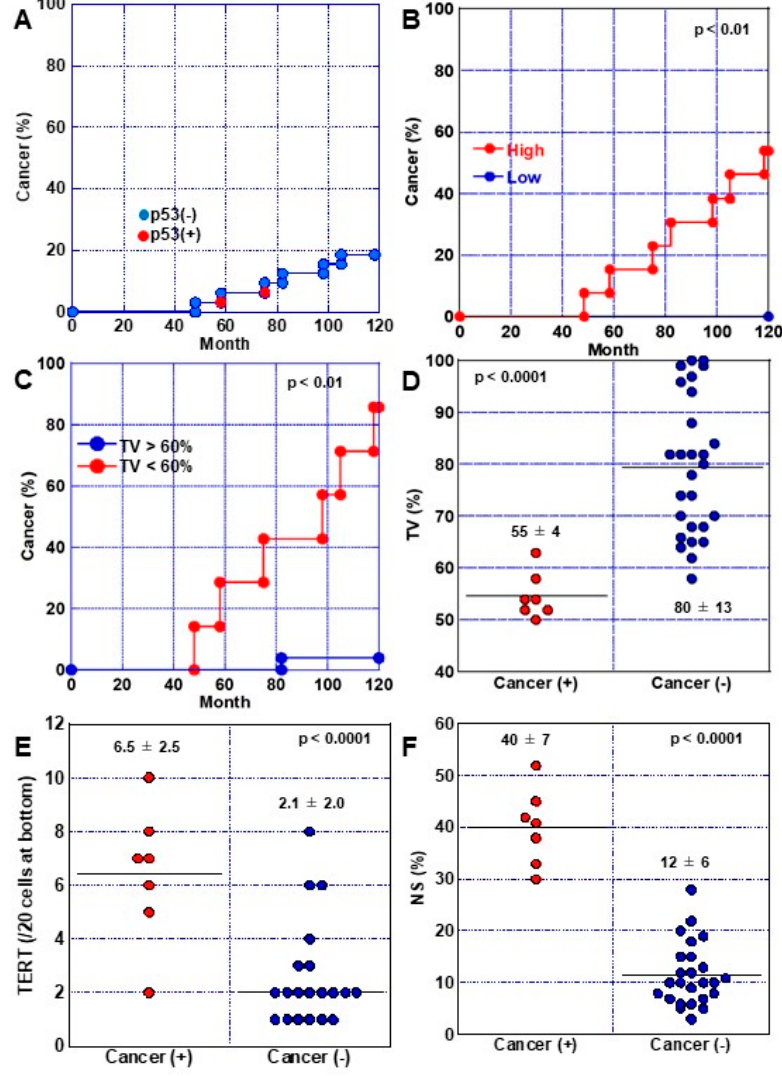
Figure 5. Comparison of DM phenotypes with/without cancer development. ( A ) Cancer develop- ment in 32 DMs. ( B ) Comparison of cancer development between high-grade and low-grade DMs. ( C ) Comparison of cancer development between lowTV (<60%) and high-TV (>60%) DMs. ( D – F ) TV ( D ), TERT expression ( E ) and stem cell number ( F ) were compared between DMs with/without cancer development. Data in panels, mean ± SD. DM, dysplastic metaplasia; High, high-grade DM; Low, low-grade DM; TV, telomere volume; TERT, telomerase reverse transcriptase; NS, nucle- ostemin.